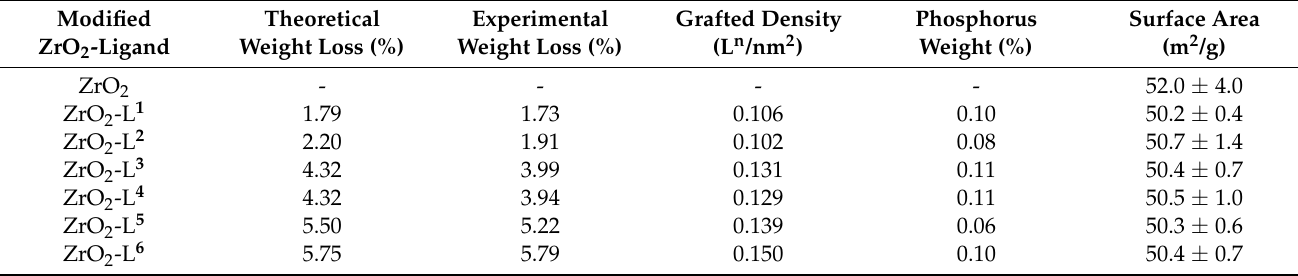
Table 2. Physico-chemical properties of ZrO 2 -L n